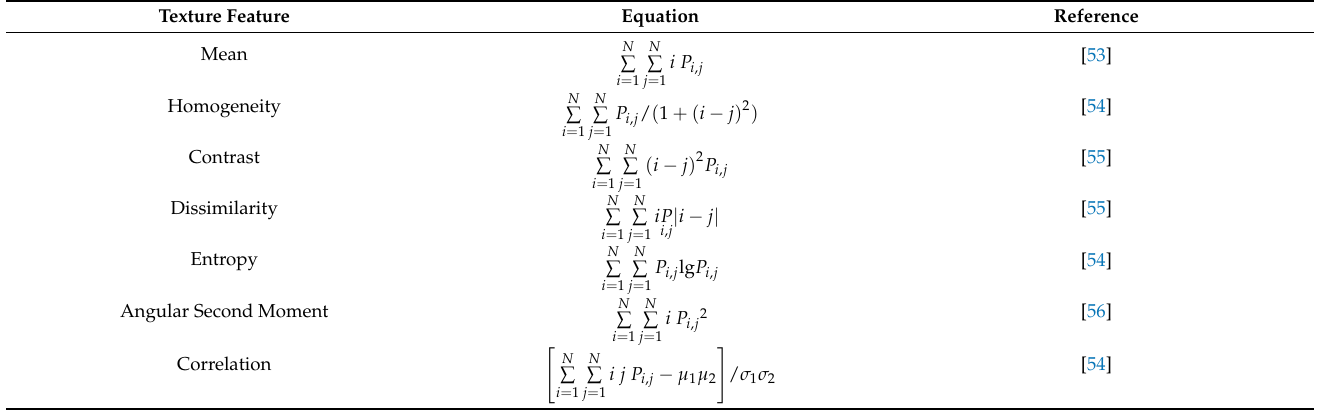
Table 3. Seven texture factors and corresponding equations ( N : order of GLCM, µ : mean, σ : standard deviation, P i,j : ( i,j )th entry in the